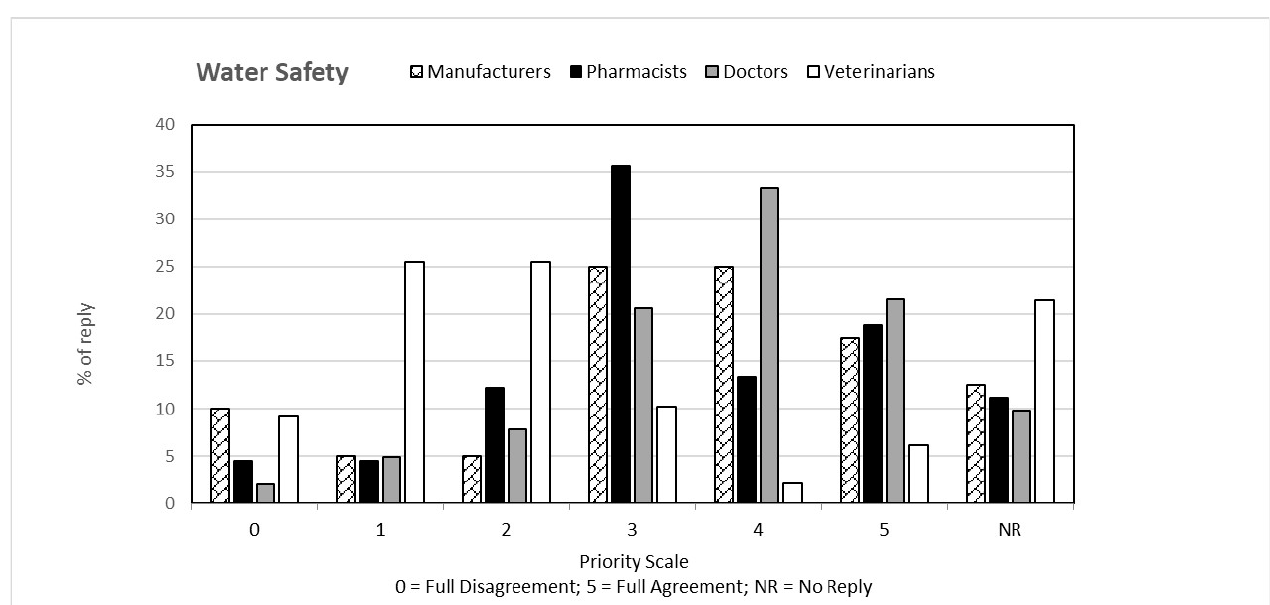
Figure 5. Percentage of answers “WATER SAFETY” to the question “Global Environmental Changes manifest themselves with ....” given by the four interviewed categories. The tables also include the percentage of “no reply” (NR) responses.